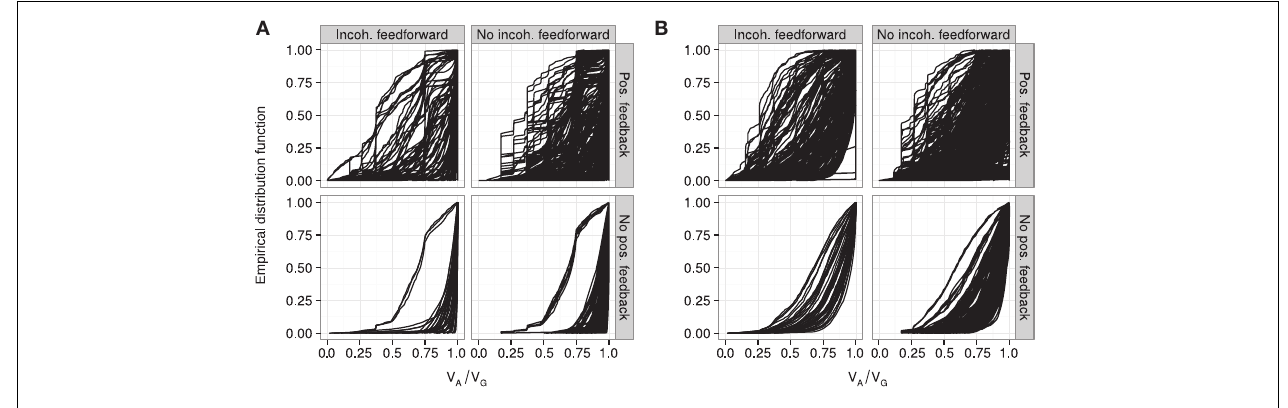
and1090 motifs with a genotype-to-parameter map with pleiotropy (B) . Each panel is divided into 4 subplots containing classes of motifs based on the presence/absence of incoherent feedforward and positive feedback loops, see Table 1 for the number of motifs in each class. Each curve shows, for a single motif, the empirical distribution function value (y-axis) of V A / V G from unweighted regression for all GP maps